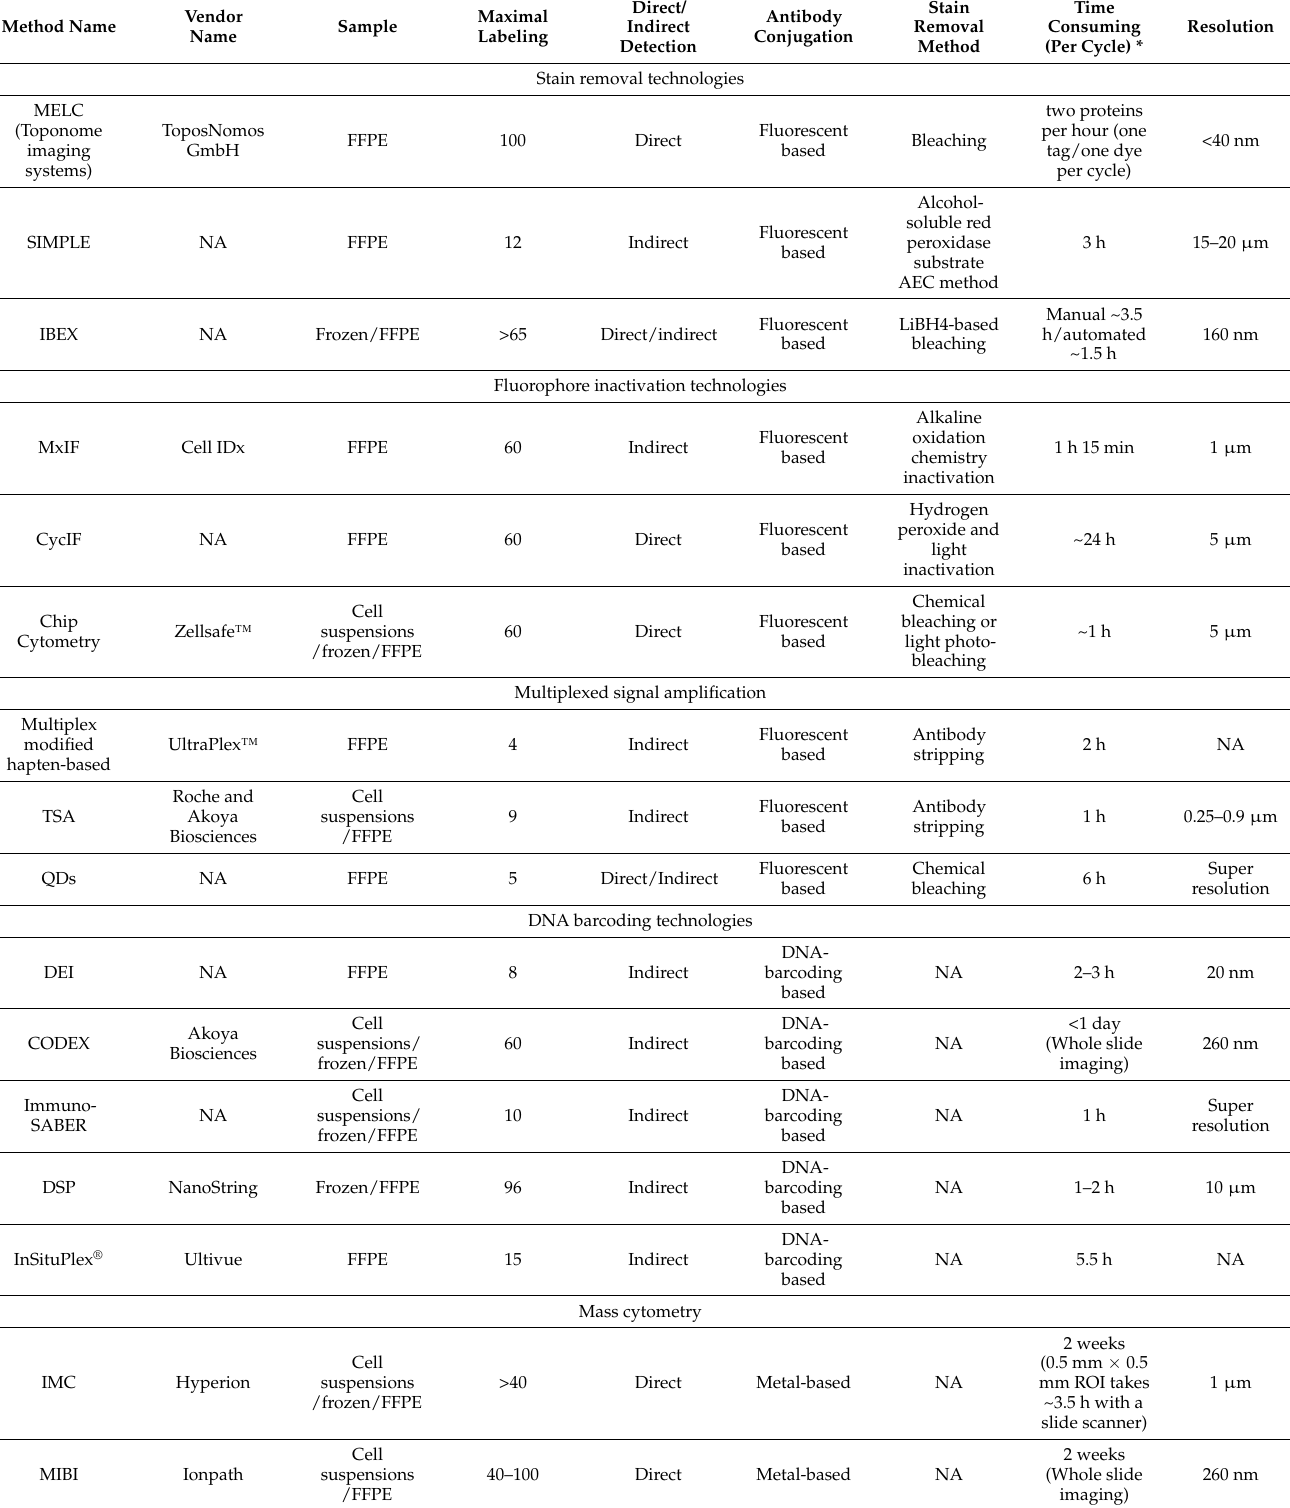
Table 1. Overview the mfIHC